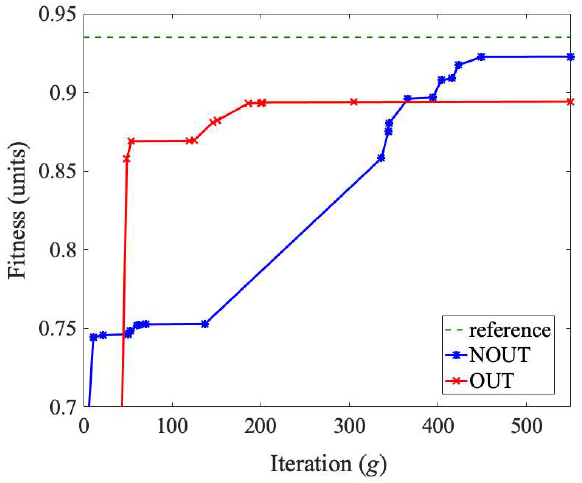
Figure 13. Fitness function improvements.